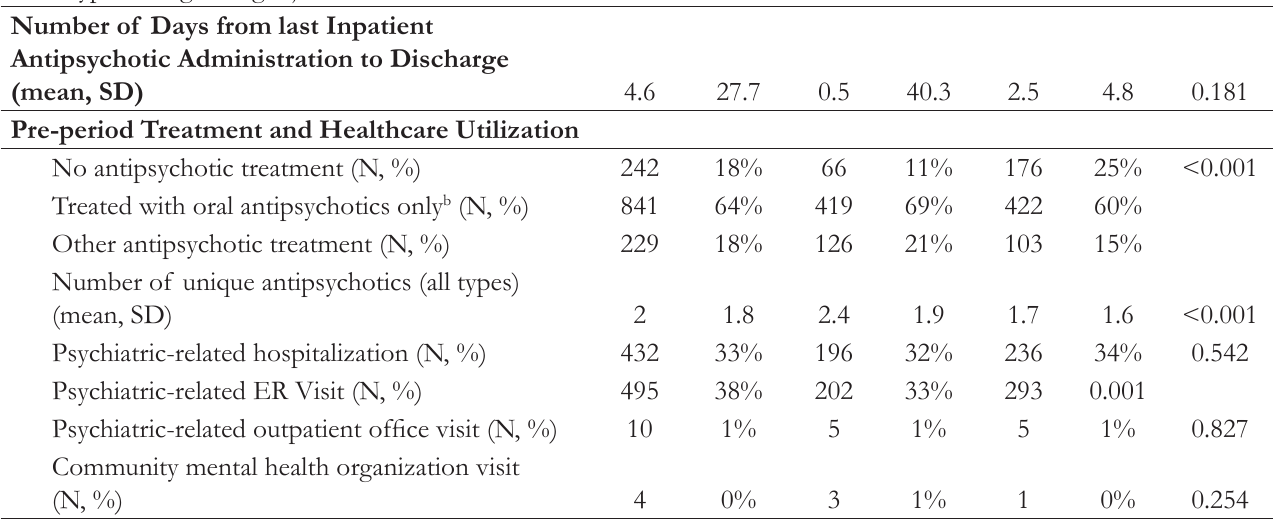
Follow-Up No Follow-Up Visit N = 611